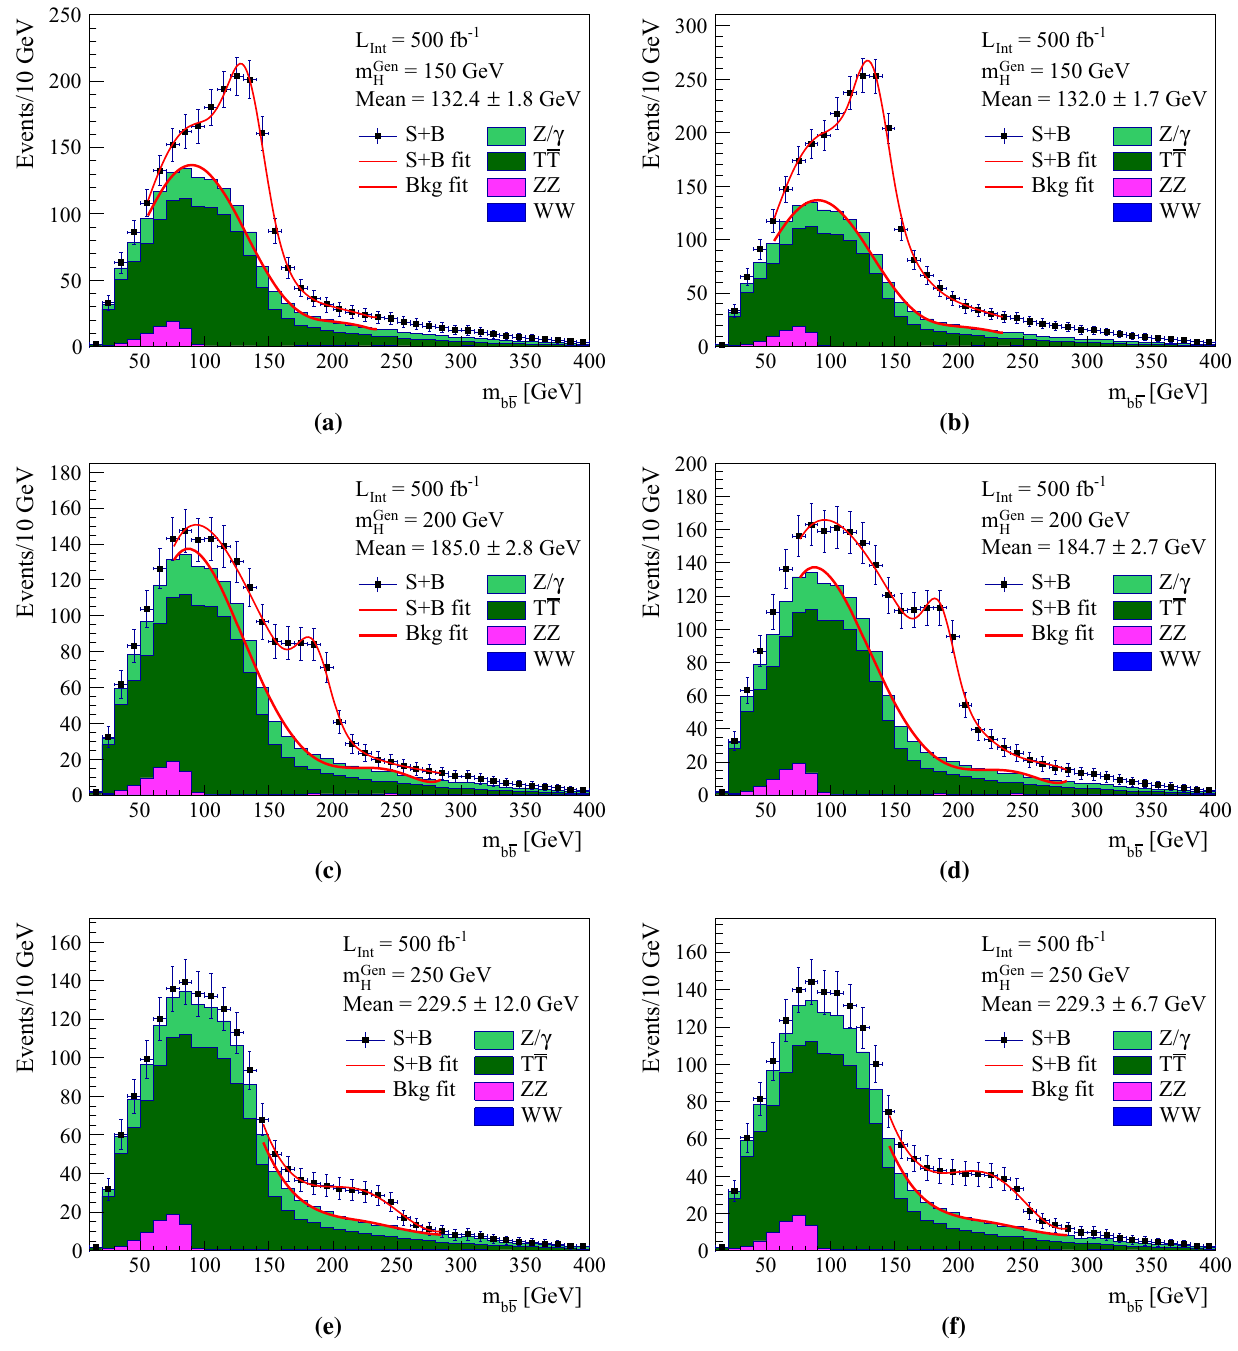
Fig. 5 Candidate mass distributions of the a – f H and g – l A Higgs bosons with corresponding fitting results and errors in different scenarios at √ s = 1000